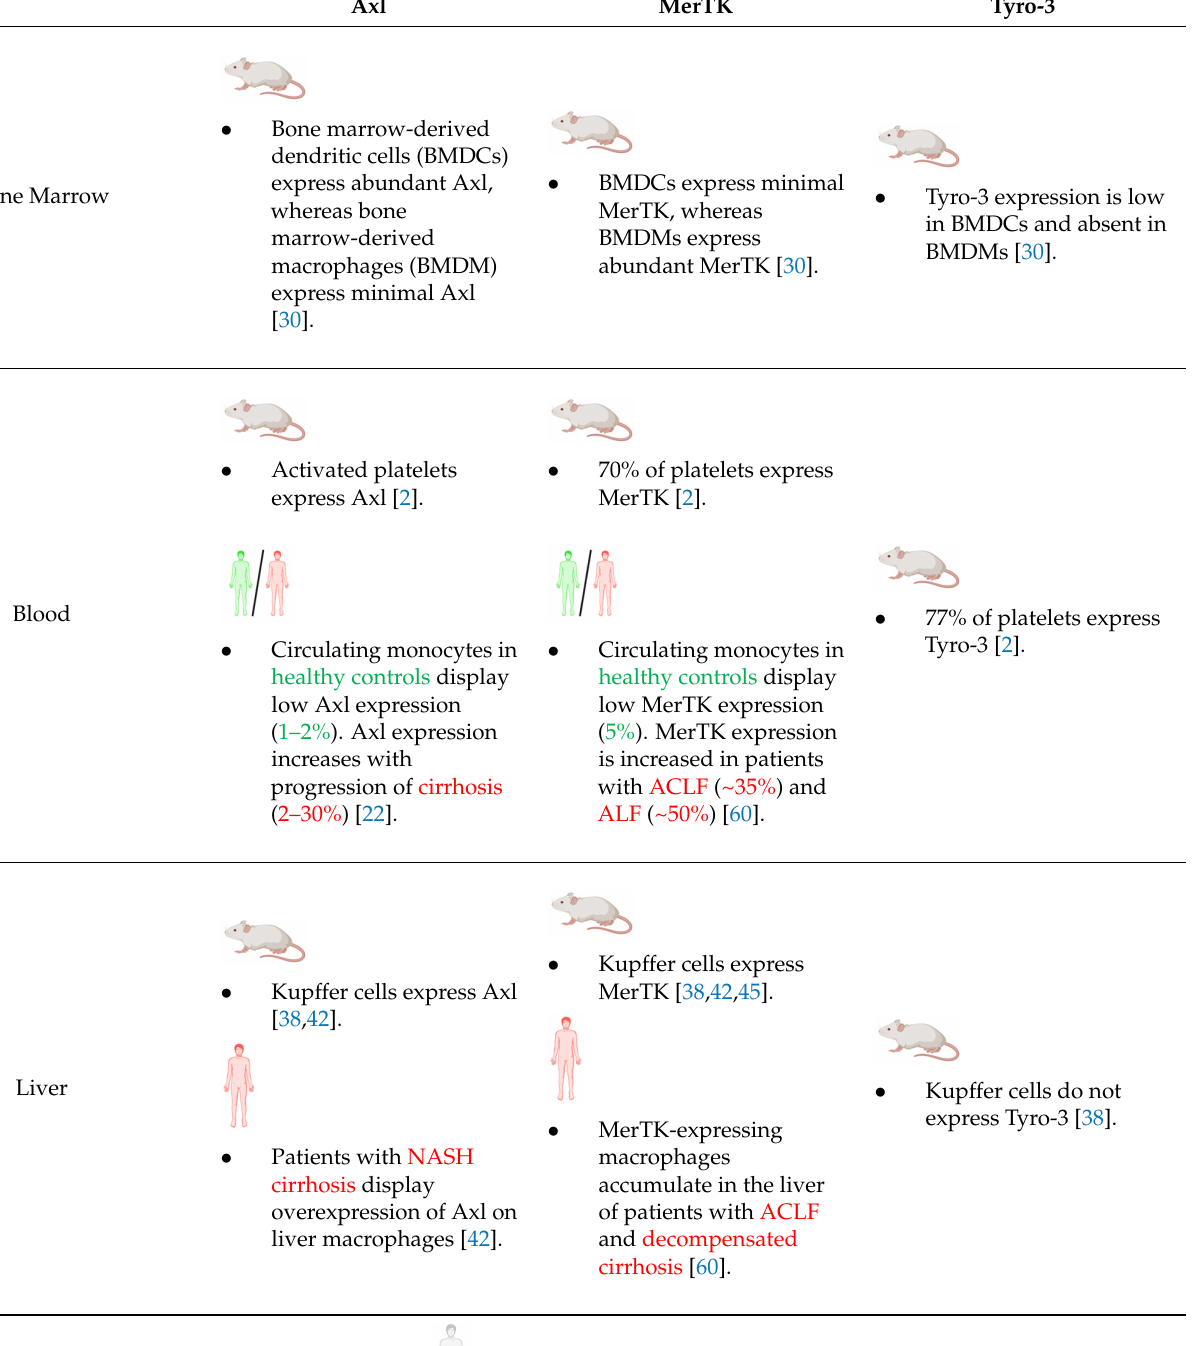
Table 1. TAM receptor expression in myeloid cell subsets in liver and extrahepatic compartments. Axl MerTK